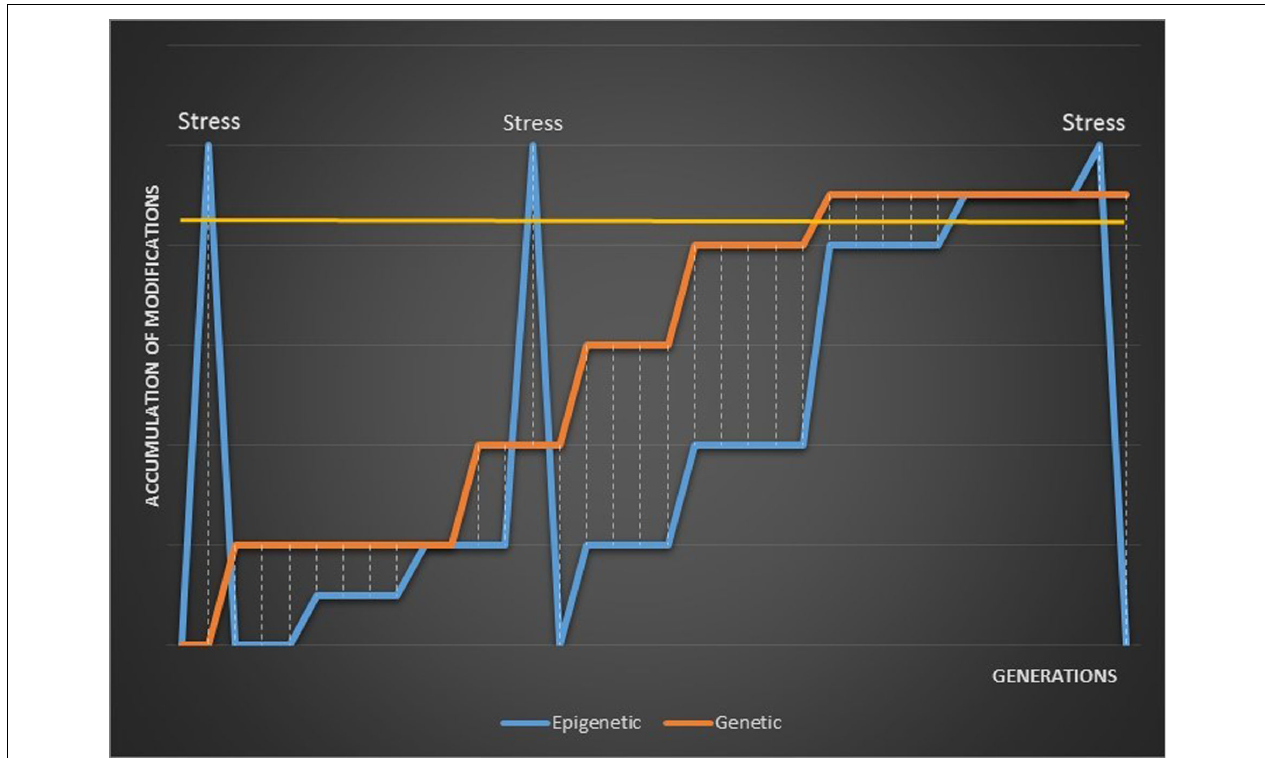
FIGURE 1 | A model of the distance between epigenetic and genetic variation when epigenetic modifications accumulate following stress and are re-set between generations. Phenotypic variation is only visible above the gold, horizontal line. The distance between epigenetic modifications and accumulating genetic mutations is illustrated by the dashed